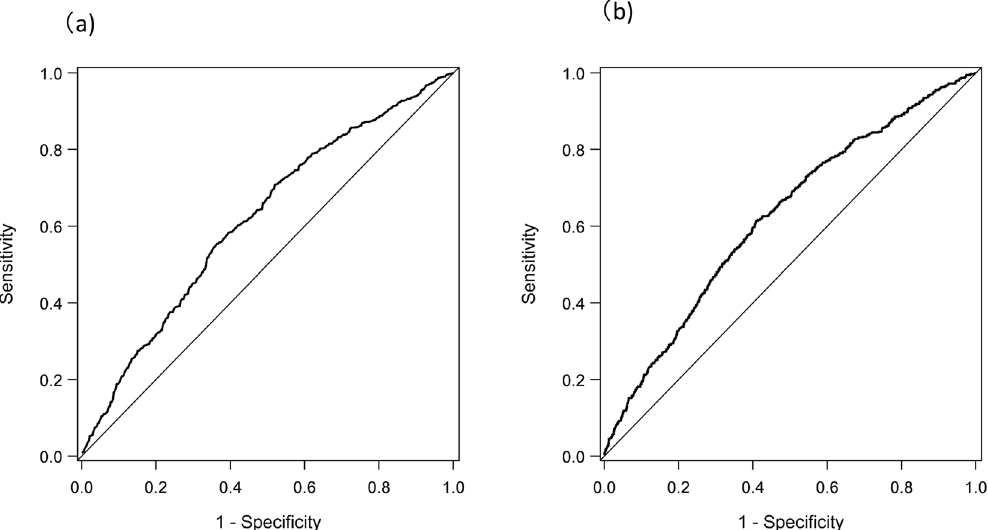
Figure 1. The covariate-adjusted receiver-operating characteristics curve of gestational weight gain for a light- for-date infant ( a ) and for a heavy-for-date infant ( b ). The receiver-operating characteristics curve of gestational weight gain in the risk for a light-for-date infant ( a ) and for a heavy-for-date infant ( b ) was drawn based on Pepe & Longton method. Adjusted avariables selected at a stepwise multivariable logistic analysis included